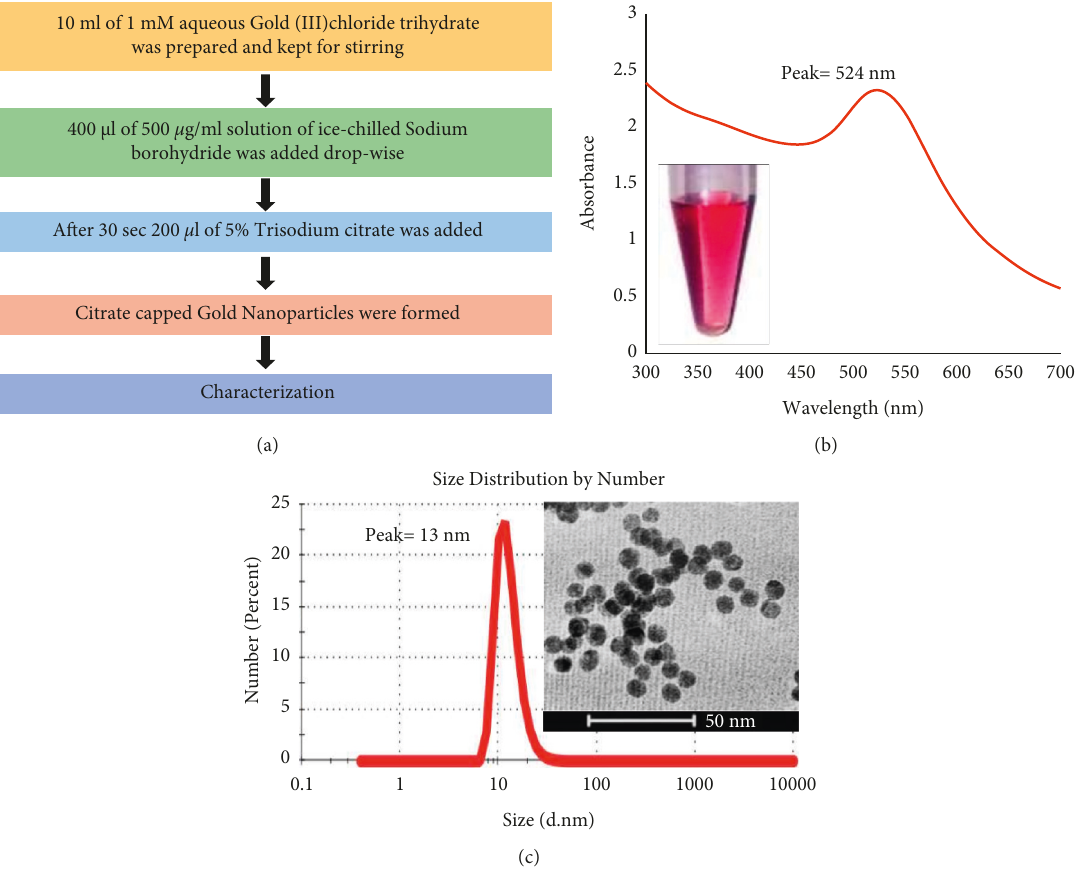
Figure 2: Synthesis and characterization of GNPs. (a) Two-step chemical reduction method of GNP synthesis. In this two-step method, reduction was achieved by addition of sodium borohydride and stabilization was carried out by trisodium citrate dehydrate. (b) Char- acterization of GNPs for its colour using visual observations and absorbance using the UV-visible spectrophotometer. (c) Characterization of GNPs for its size distribution using Zetasizer and shape using the transmission electron microscope